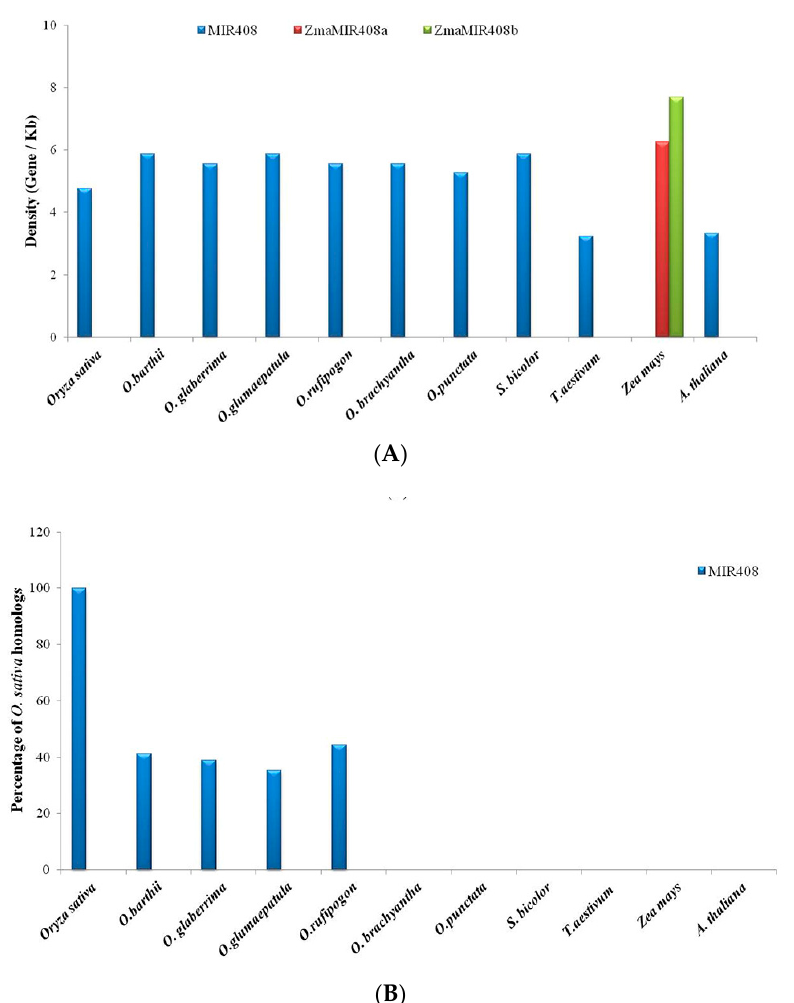
Figure 4. Graphical representation of ( A ) percentage of O. sativa homologs in 100 kb genomic segments harboring MIR408 conserved among O. sativa , other poaceae members, and Arabidopsis ; ( B ) density of genes present in 100 kb genomic segments harboring MIR408 across different poaceae members and Arabidopsis .